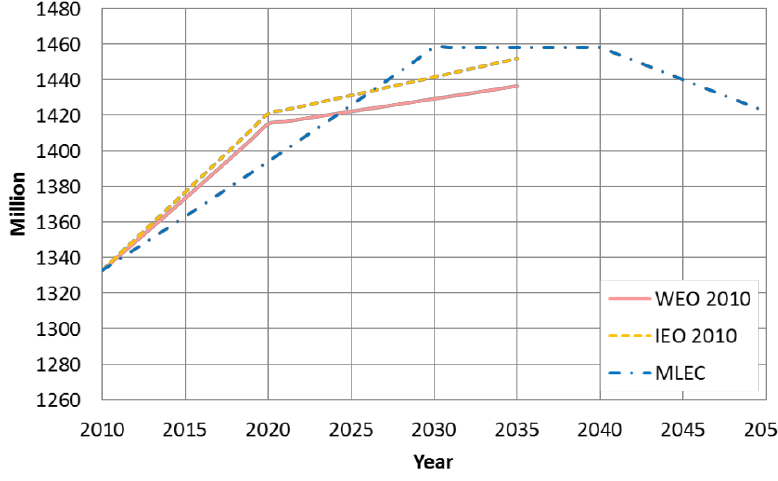
Figure 9. Population growth setting in all scenarios of projected energy consumption of China.